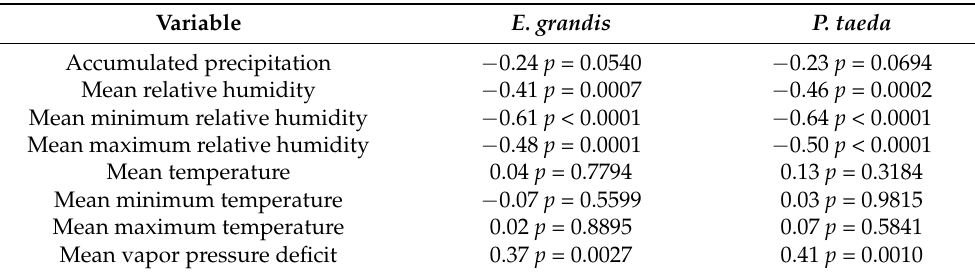
Table 5. Spearman’s correlation coefficients between the proportion of remaining litter and seasonal climatic variables ( n = 63).